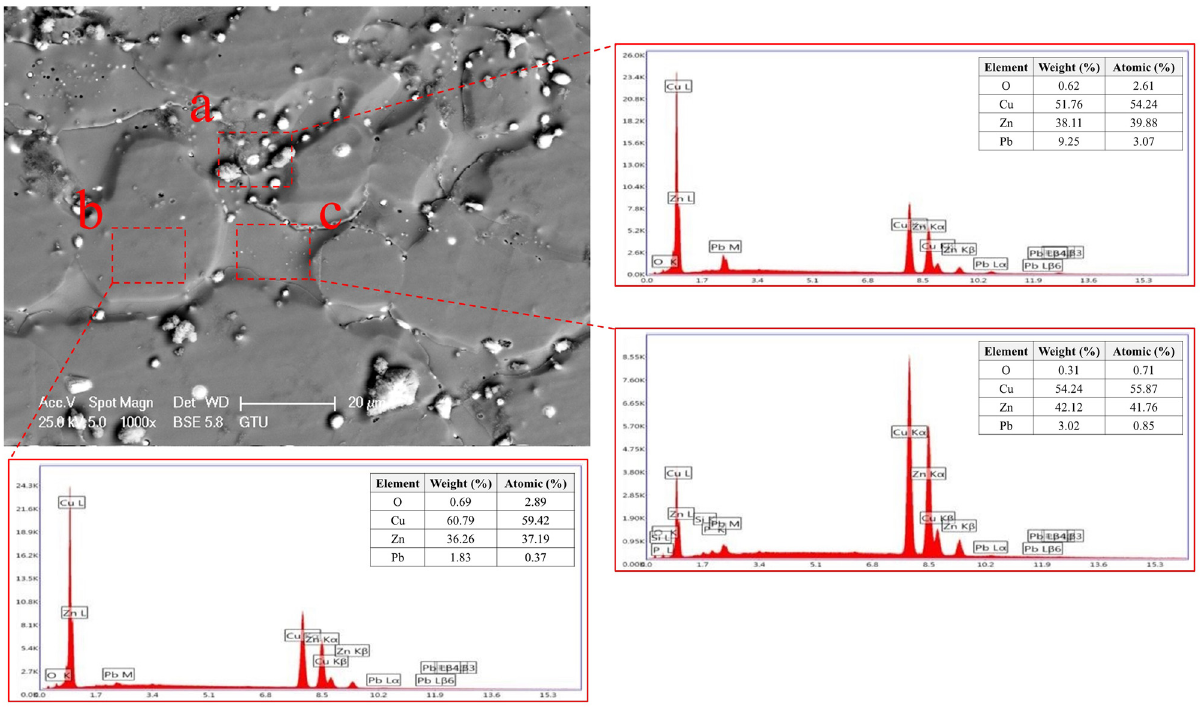
Figure 5: The results of EDS analysis from regions labeled ( a – c ) in the SEM image of